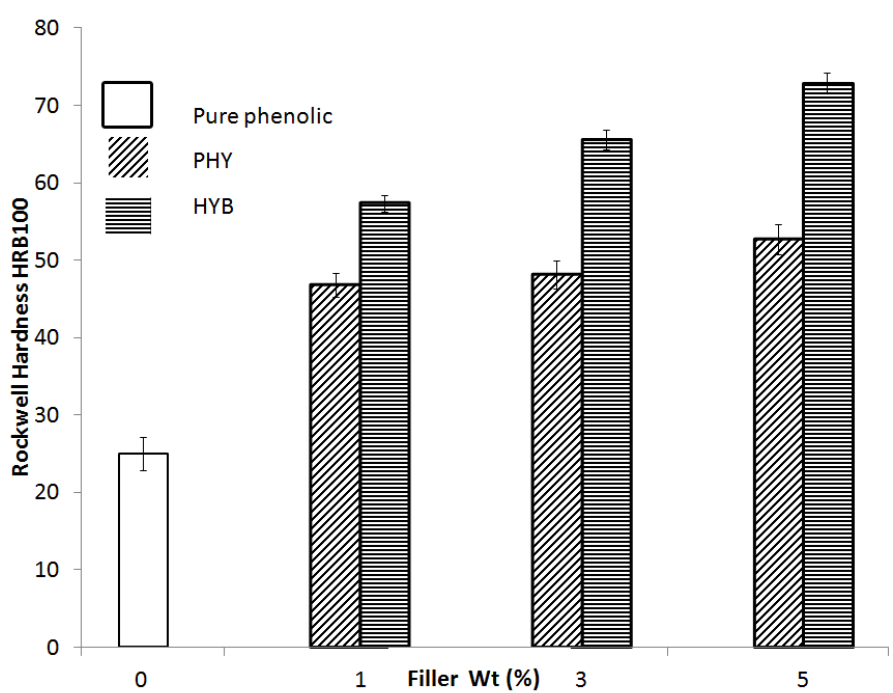
Figure 8. Hardness number of the HYB composite and PHY composite as a function of filler loading.